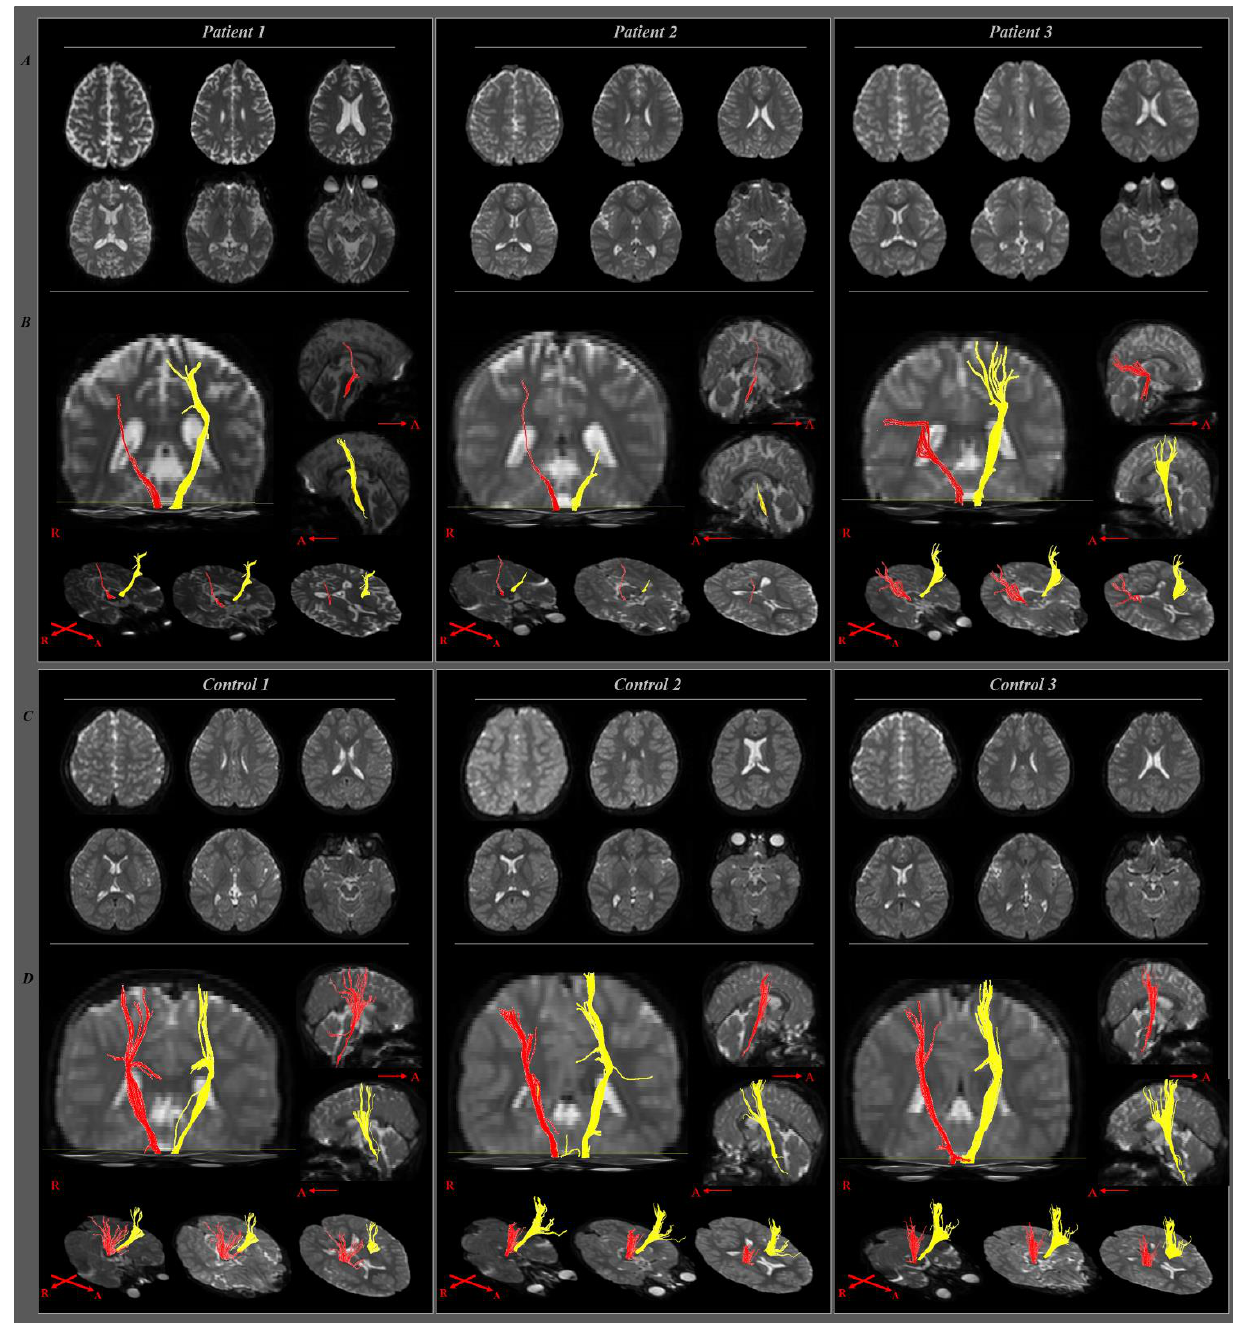
Figure 2. Diffusion tensor tractography of the corticospinal tract in patients and control participants. ( A ) and ( C ) show T2-weighted images of conventional magnetic resonance imaging, which reveal no definite abnormal findings. ( B ) and ( D ) show diffusion-tensor tractography of the corticospinal tract. Patients 1 and 3 exhibit disrupted integrity of the right corticospinal tract, and patient 2 exhibits disrupted integrity of the left corticospinal tract. Control participants have preserved integrities of both corticospinal tracts. Red indicates the right corticospinal tract and yellow indicates the left.